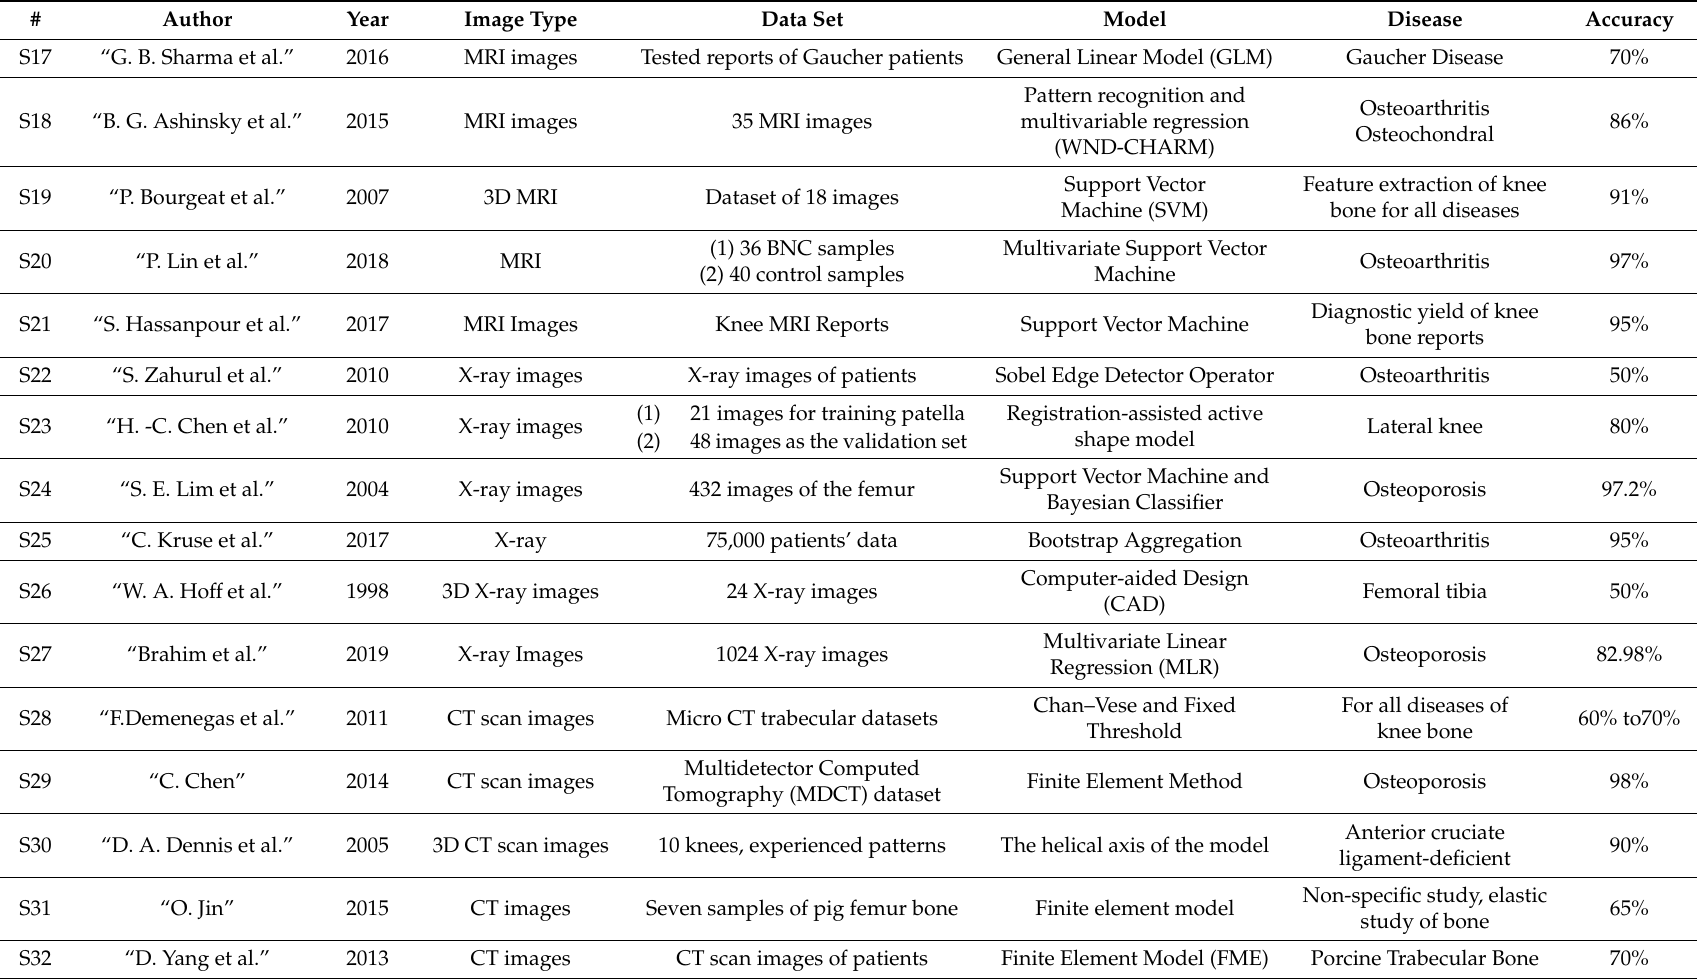
Table 10. Extracted data for knee bone-related MRI, CT scans, and X-rays using machine learning